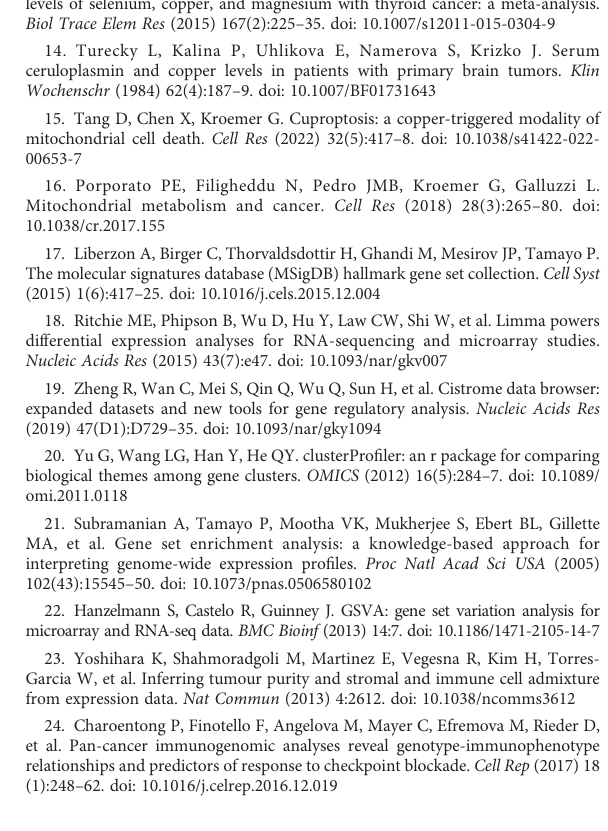
SUPPLEMENTARY FIGURE 3 Genetic alterations of LUAD in TCGA (A) Mutation of all LUAD in TCGA. (B) Mutation statistics in high-risk group. (C) Mutation statistics in low- risk group. SUPPLEMENTARY FIGURE 4 Evaluation of response to immunotherapy. Difference of risk score in different IC expression (A) , TC expression (B) and immune phenotype (C) in IMvigor210